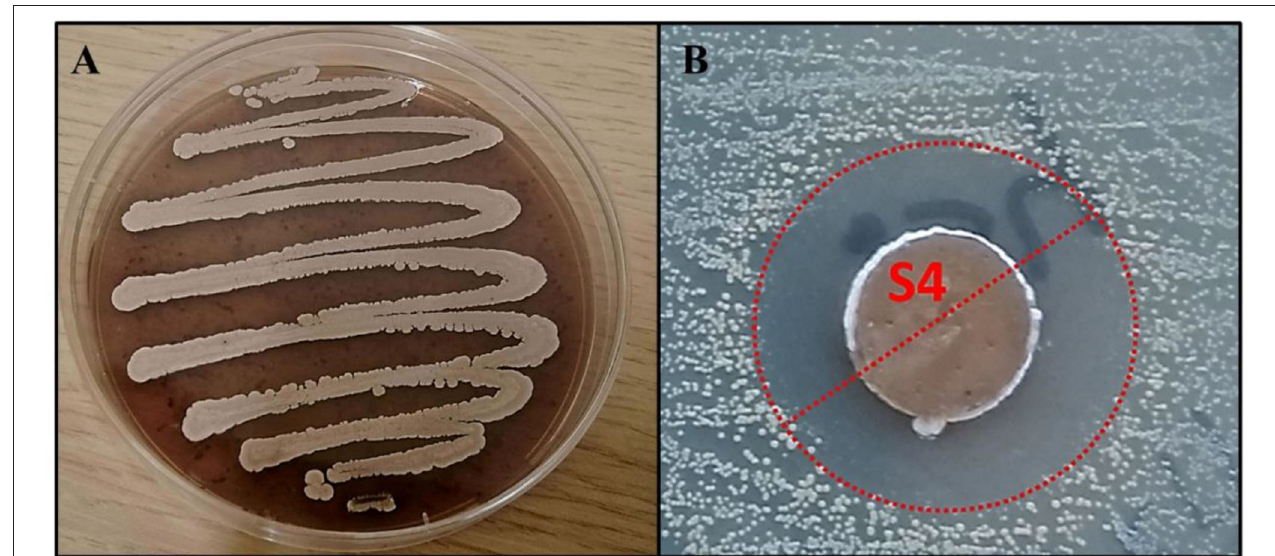
FIGURE 1 | (A) The morphological appearance of Streptomyces sp. RO-S4 strain grown on M2 medium for 12 days at 28 ◦ C. (B) MRSA inhibitory potential of the RO-S4 strain evaluated by the agar diffusion method.